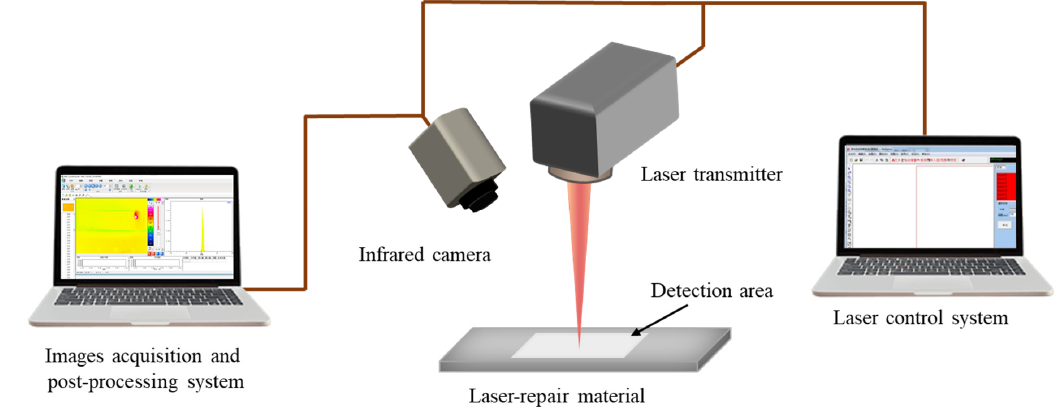
Figure 11. Crack detection system based on laser scanning thermography [10,37].